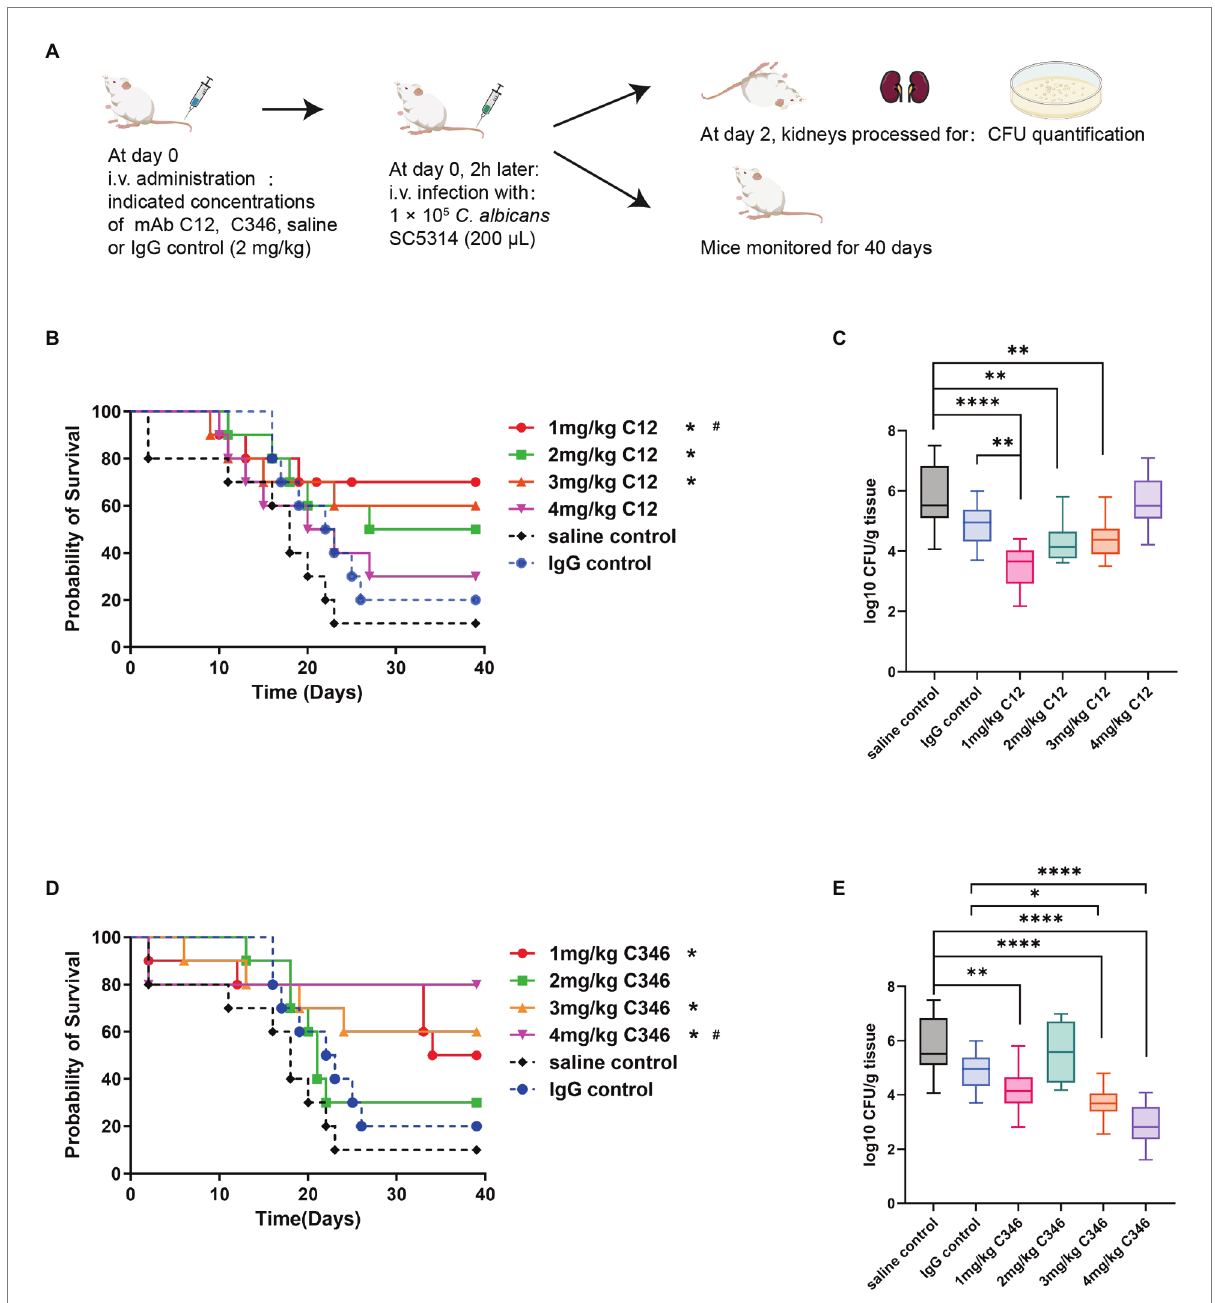
FIGURE 2 The in vivo antifungal efficacy of anti-rPmt4p mAbs in the murine model of disseminated candidiasis. (A) Schematic process of pre-treatment with mAb C12 or mAb C346 in the murine model of disseminated candidiasis. (B,C) Mice were prophylactically administrated 1, 2, 3, 4 mg/kg of mAb C12, saline, or 2 mg/kg of IgG. Two hours later, mice were challenged with 1 × 10 5 C. albicans SC5314 cells/mouse via the lateral tail vein. (B) The Kaplan–Meier survival curves of mice monitored for 40 days post-inoculation ( n = 10 per group). (C) Quantification of fungal burden in the kidneys from mAb C12 treated mice on day 2 post-infection (n = 6 per group). (D,E) Mice were prophylactically administrated 1, 2, 3, 4 mg/kg of mAb C346, saline, or 2 mg/kg of IgG. Two hours later, mice were challenged with 1 × 10 5 C. albicans SC5314 cells/mouse via the lateral tail vein. (D) The Kaplan–Meier survival curves of mice monitored for 40 days post-inoculation ( n = 10 per group). (E) Quantification of fungal burden in the kidneys from mAb C346 treated mice on day 2 post-infection ( n = 6 per group). * , p < 0.05 vs. saline control group; # , p < 0.05 vs. IgG control group ( B,D ; Log-rank test). * , p < 0.05; ** , p < 0.01; **** , p < 0.0001 ( C,E ; Nonparametric One-way